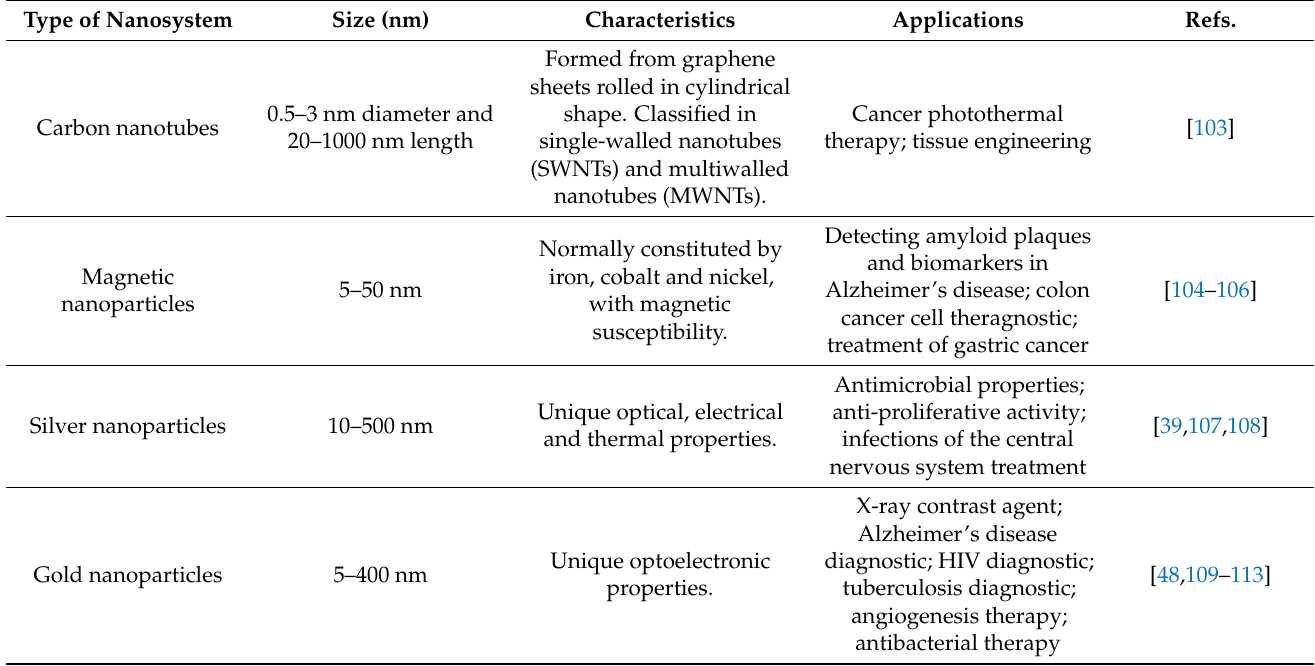
Table 2. Examples of nanosystem types, their characteristics and applications in